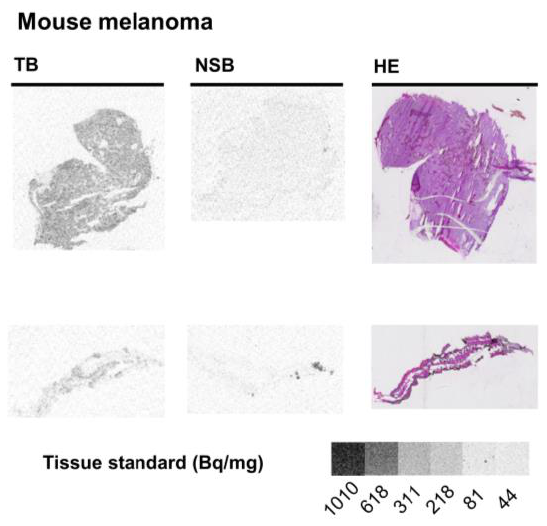
Figure 5. Representative images of sections from mouse melanoma and healthy skin. TB, total radioligand binding; NSB, non-specific binding (determined in the presence of 5 µ M FR), HE, hematoxylin-eosin staining. For autoradiography, organ slices were incubated with 10 nM [ 3 H]PSB-15900-FR for 1 h at room temperature. Tissue equivalent standards are displayed at the bottom.